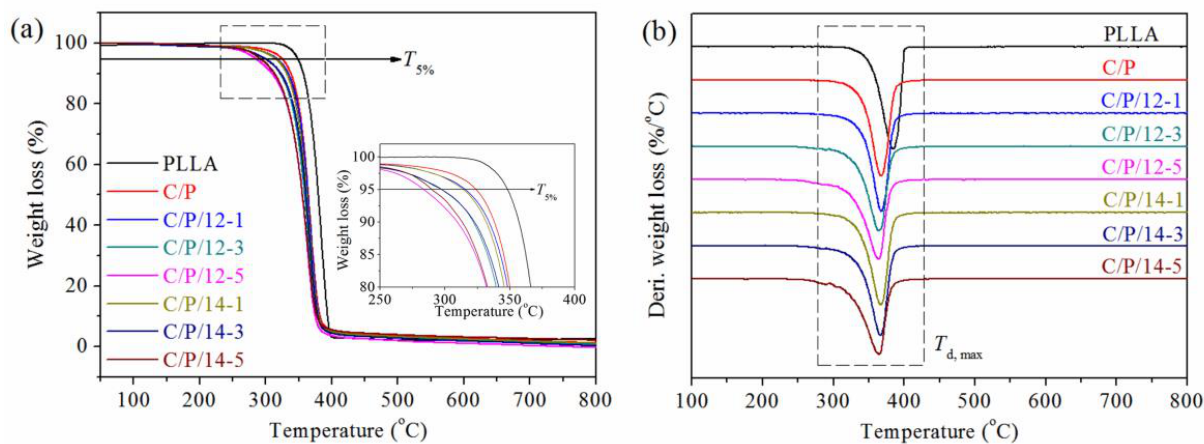
Figure 6. TGA ( a ) and DTG ( b ) curves of PLLA, C/P blend, and the composites.